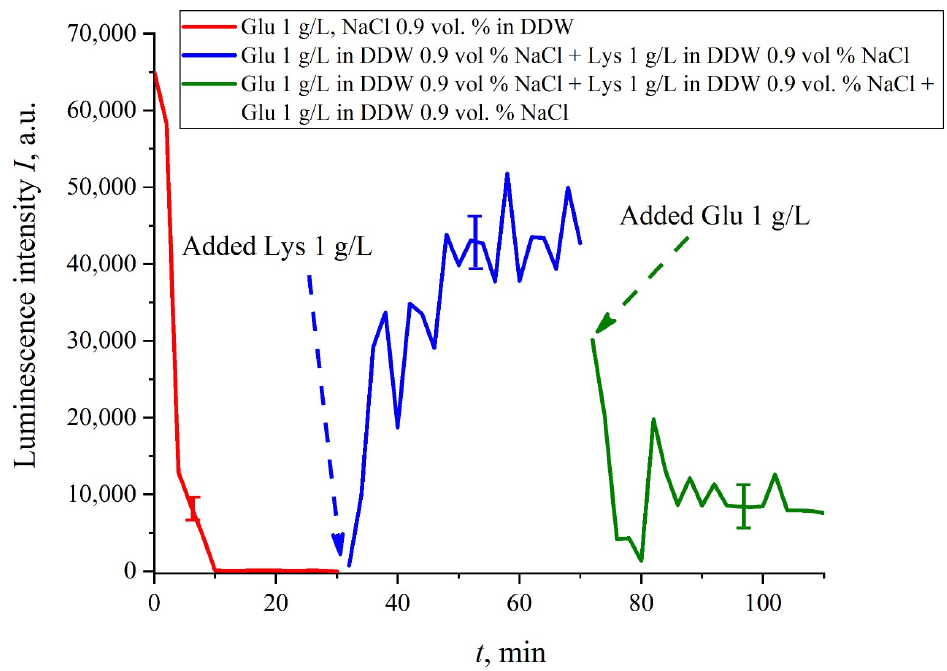
Figure 9. Luminescence intensity I ( t ) vs. soaking time in DDW- based salines (0.9 vol.% NaCl) containing the glutamic acid suspension (concentration 1 g/L). At the 30-th minute, a lysine suspension (1 g/L), prepared in DDW-based saline solution, was added; the volumes V of glutamic acid and lysine suspensions are the same. Then, at the 70-th minute, a glutamic acid suspension of the same volume V and concentration of 1 g/L, was added once again.